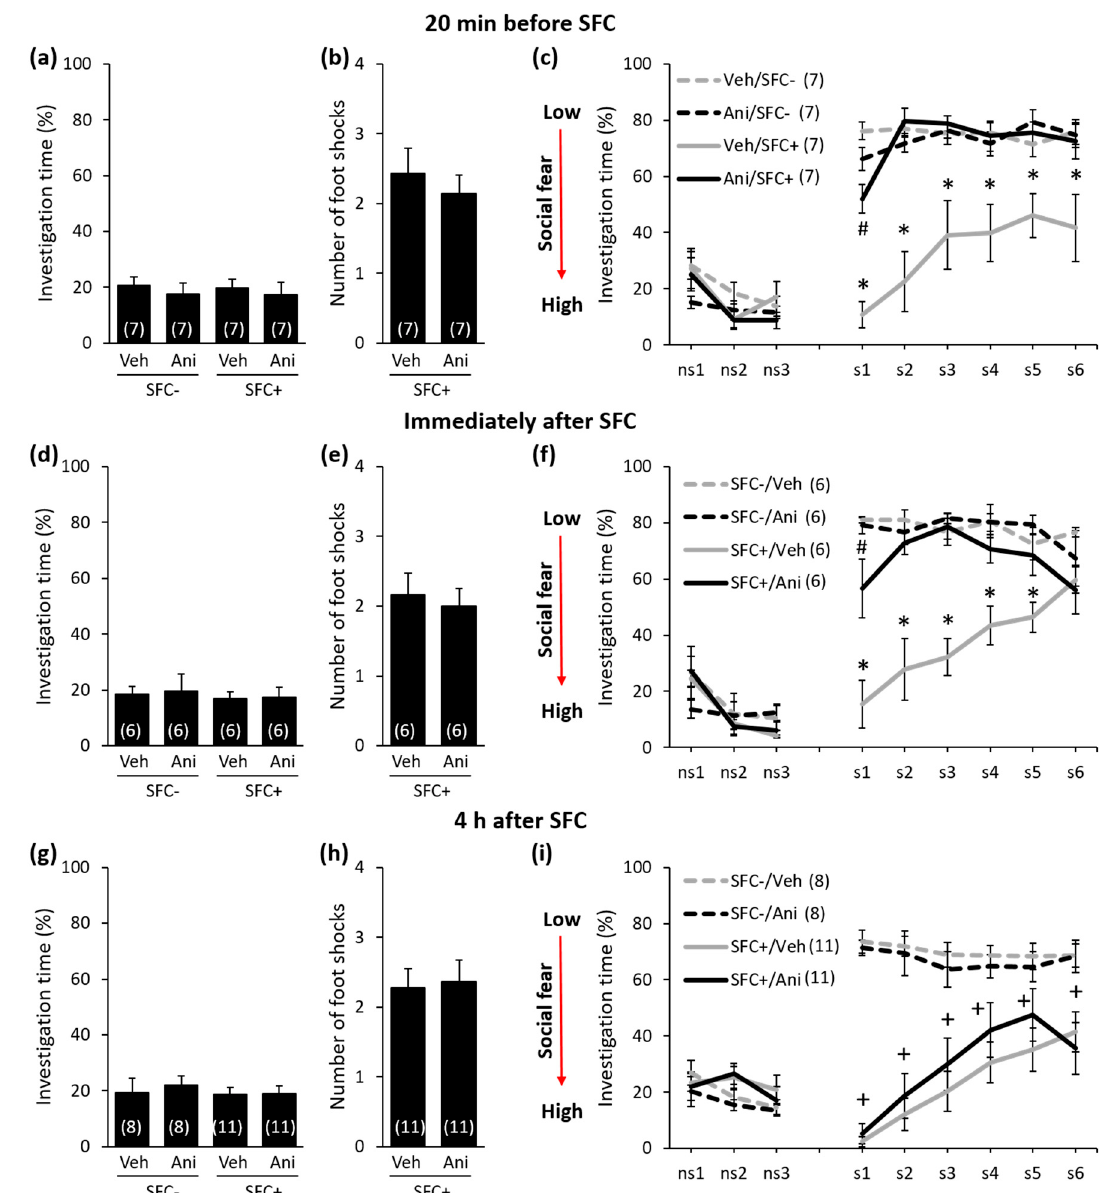
Figure 2. Anisomycin impairs the consolidation of social fear memory when administered 20 min before or immediately after social fear conditioning (SFC), but not when administered 4 h after SFC. ( a , d , g ) Pre-conditioning investigation of the non-social stimulus (empty cage) shown by unconditioned and conditioned mice (SFC − and SFC + , respectively) during SFC on day 1. ( b , e , h ) Number of foot shocks received by SFC + mice during SFC. ( c , f , i ) Investigation of the non-social (ns1–ns3) and social (cages with mice; s1–s6) stimuli during social fear extinction on day 2. Mice were injected intraperitoneally either with vehicle (Veh; 0.9% saline; 5 mL/kg) or anisomycin (Ani; 150 mg/kg) at different time-points before or after SFC. Data represent mean ± SEM and numbers in parenthesis indicate group sizes. p < 0.05 * versus all groups; # versus Veh/SFC + and Ani/SFC − ; + versus respective SFC − controls.